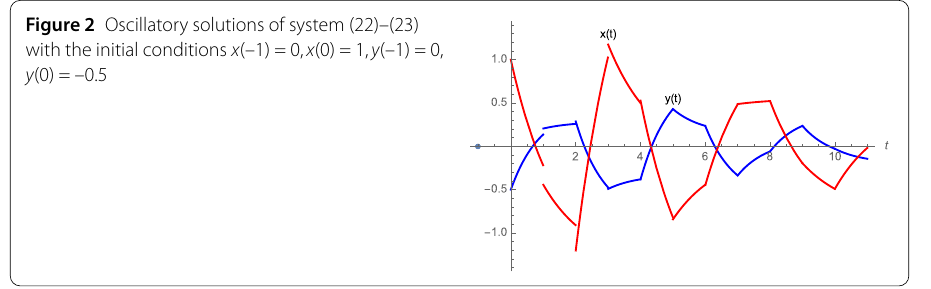
Figure 2 Oscillatory solutions of system (22)–(23) with the initial conditions x (–1) = 0, x (0) = 1, y (–1) = 0, y (0) =